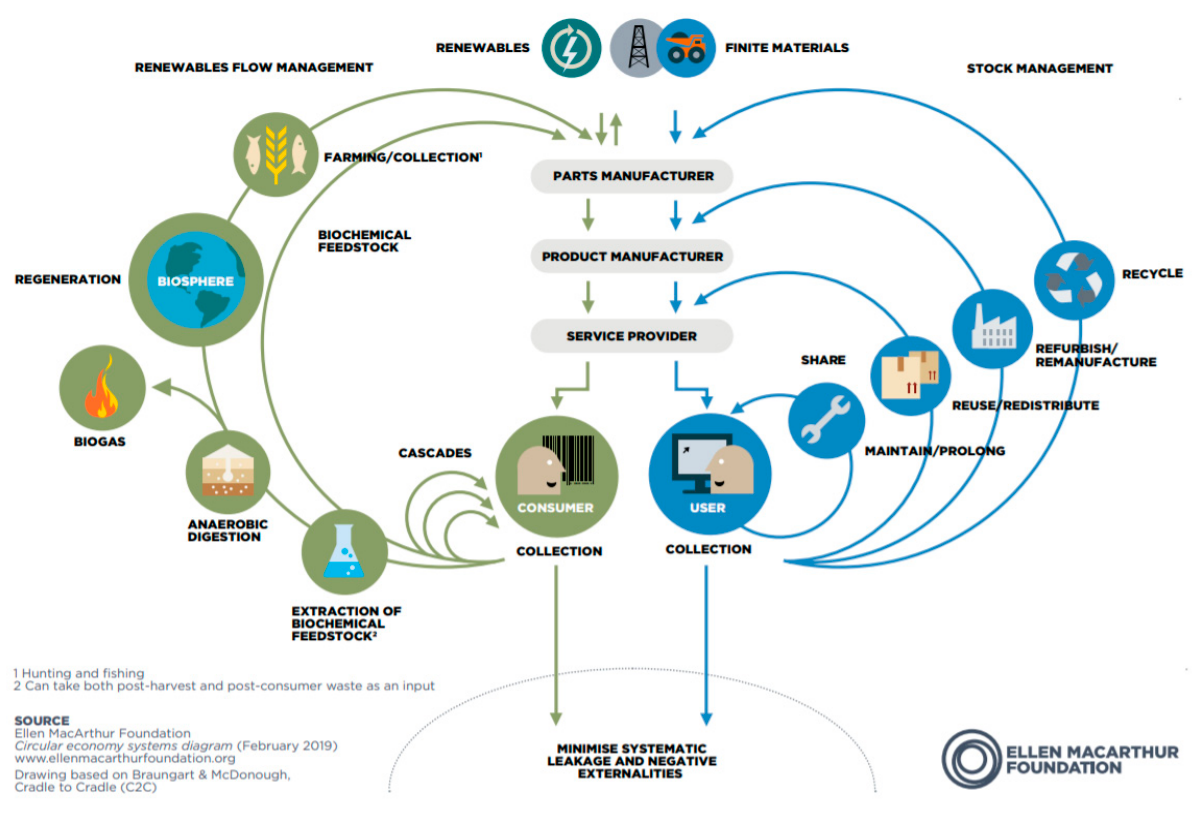
Figure 3. Butterfly diagram of systematic circular economy.